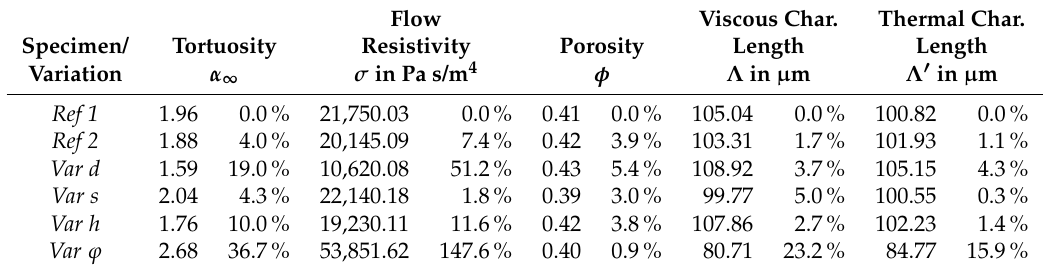
Table 3. Overview of inversely identified material parameters and variation relative to Ref 1 specimen. Flow Viscous Char. Thermal Char. Specimen/ Tortuosity Resistivity Porosity Length Length Variation α ∞ σ in Pa s/m 4 Λ in µ